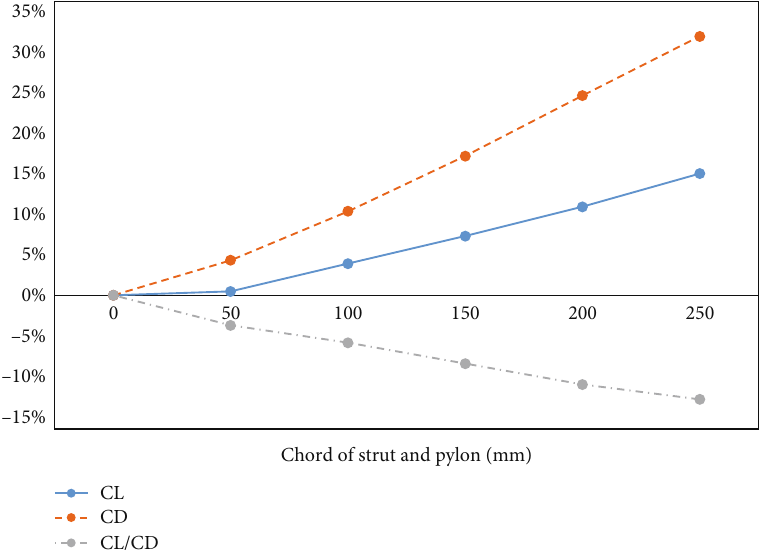
Figure 7: In fl uence of the strut chord on the lift-drag